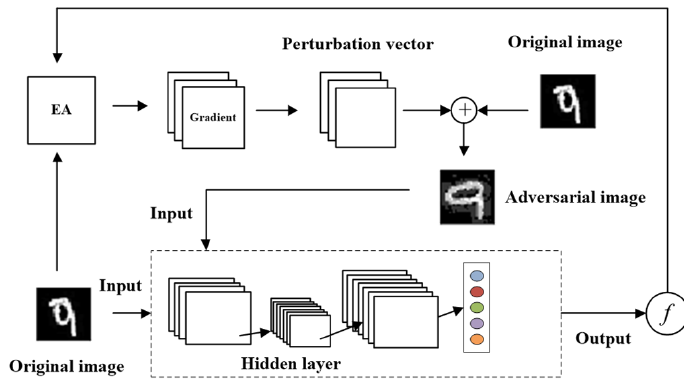
Figure 1. The SAGM framework.